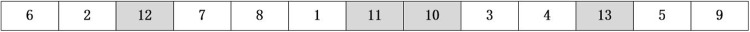
Situation 2 of dead solutions.